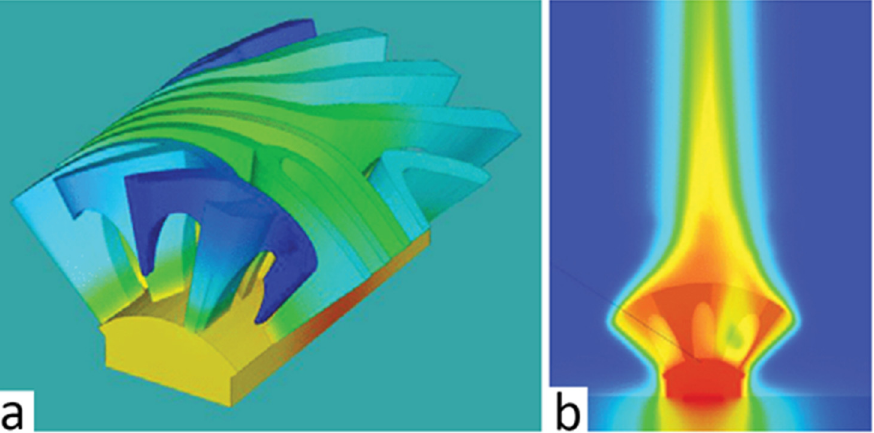
Figure 7. Simulated temperature ( a ) and airflow ( b ) of the passive heat sink with freeform geometry reprinted with permission from Ref. [61]. Copyright 2018 [61].